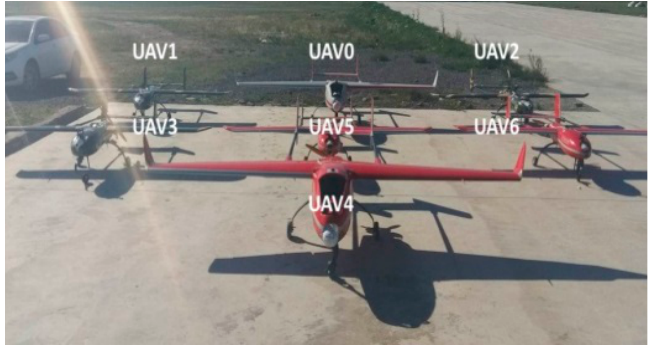
Figure 7. Seven UAVs.